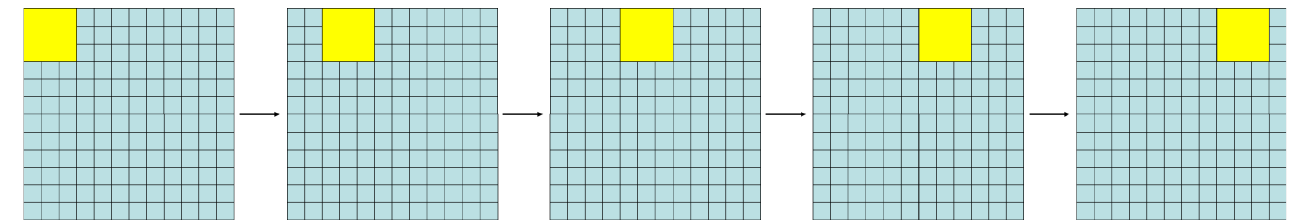
Appl. Sci. 2023 , 13 , 2691 Figure 6. Convolution process with a stride of two. Figure 6. Convolution process with a stride of two.